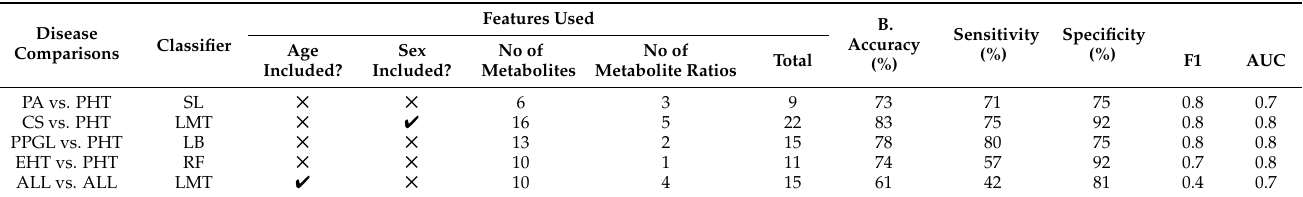
Table 3. Classification results for disease comparisons showing balanced accuracy, sensitivity, speci- ficity, F1 score, and AUC for the test set (Phase 3). It includes the breakdown of features and highlights whether age and sex were selected amongst them.